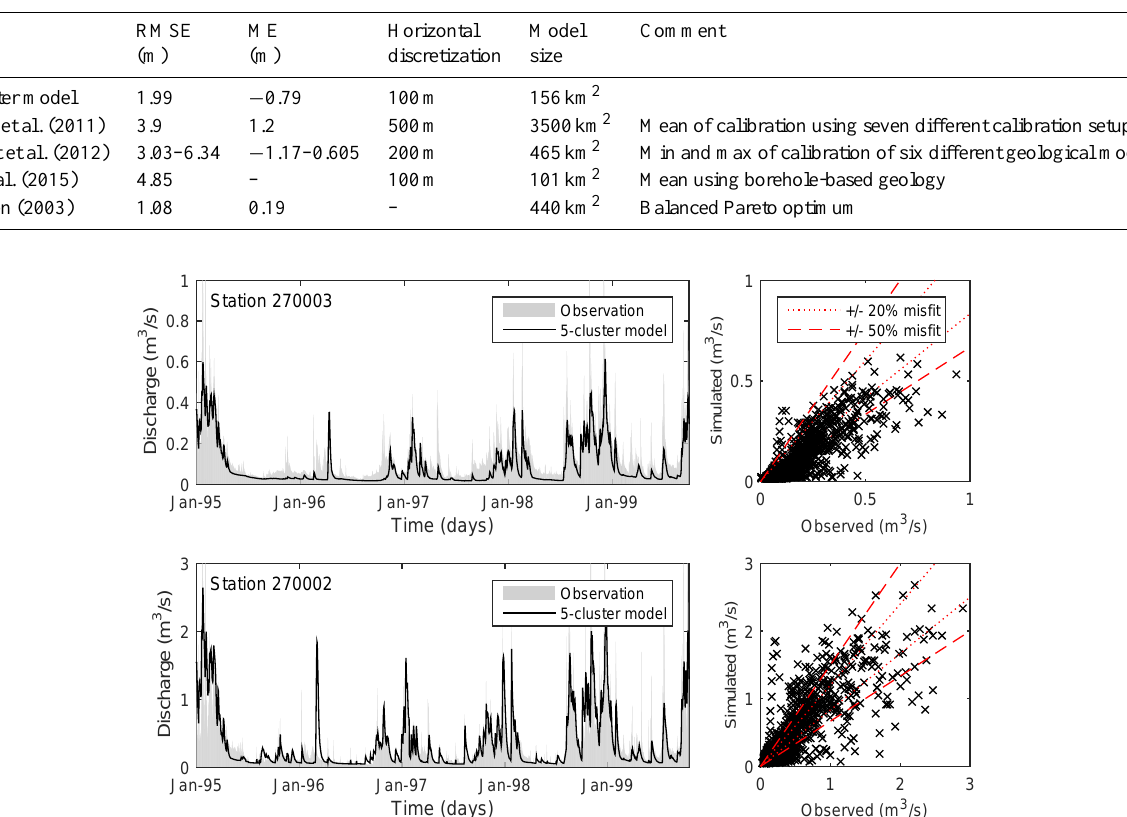
Table 2. Performance statistics of four Danish hydrological models that are comparable to the Norsminde model. All models are set up using MIKE SHE.